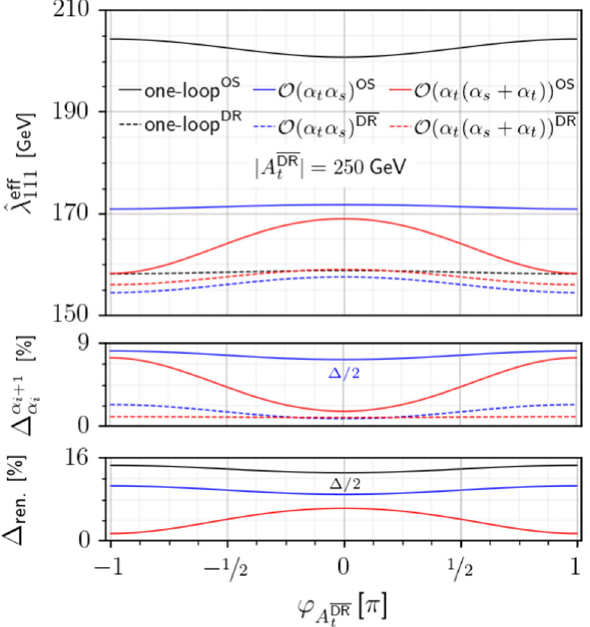
of the h u -dominated Higgs 111 for | A DR t | = 250 GeV. t